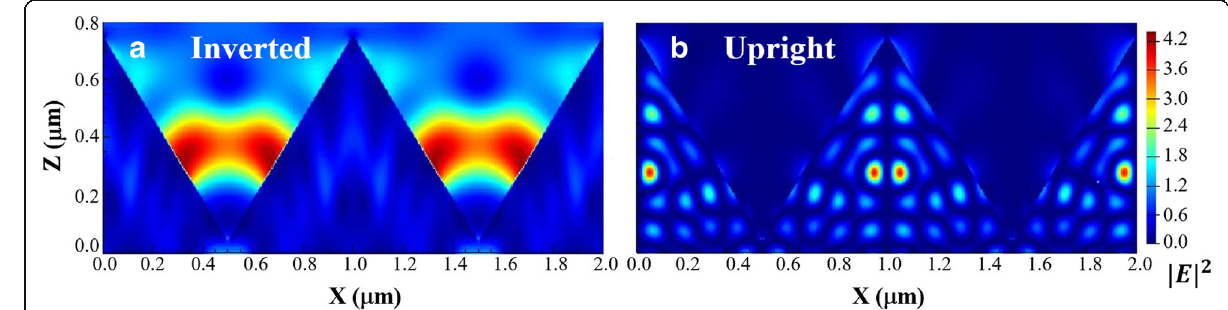
Fig. 7 FDTD simulation of electric field intensity distribution in inverted/upright pyramid structure sc-Si. 3D FDTD simulation of electric field intensity distribution in inverted/upright pyramid structure sc-Si. Inverted/upright pyramid size are designed at 1 μ